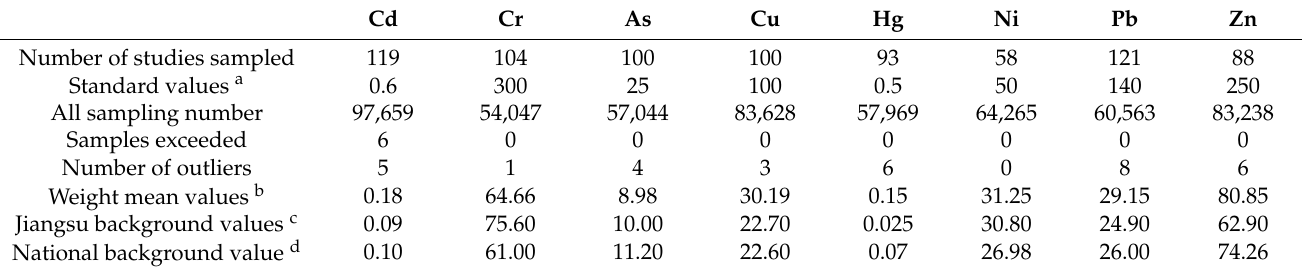
Table 1. Statistics on the weighted mean values of heavy metals in Jiangsu agricultural soil (mg/kg). Cd Cr As Cu Hg Ni